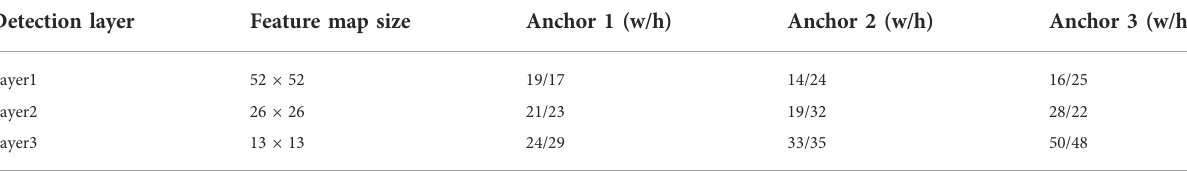
TABLE 1 Setting of anchor sizes (Unit: pixels).